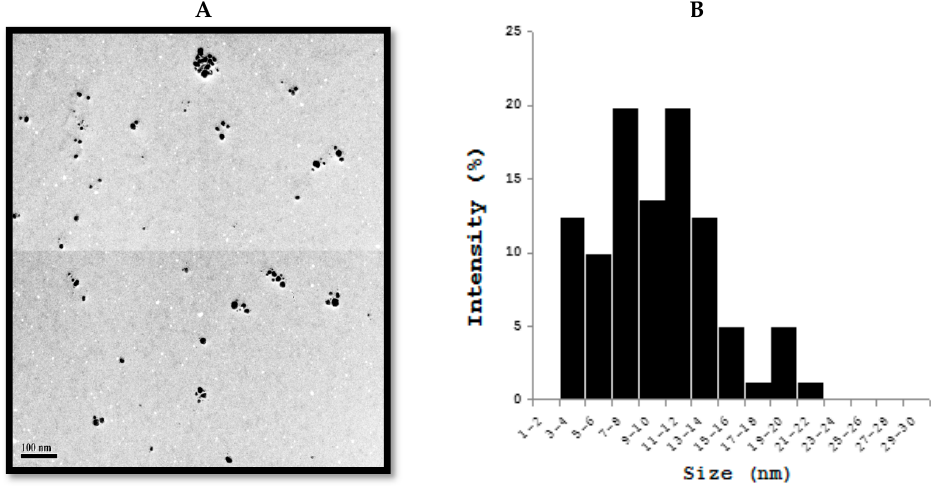
Figure 2. Transmission electron microscopy (TEM) of silver nanoparticles (AgNPs) ( A ) TEM images of AgNPs synthesized by culture supernatant of Bacillus marisflavi ( B ). Size distribution of AgNPs from TEM images.